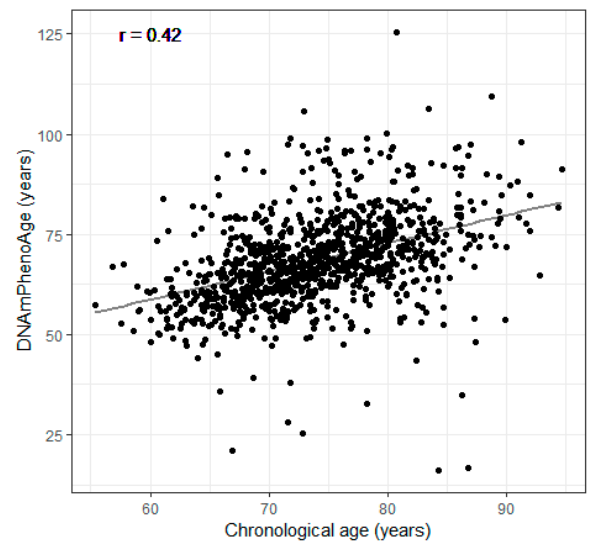
Figure 2. Scatter plot of the DNA methylation phenotypic age (DNAmPhenoAge) and the